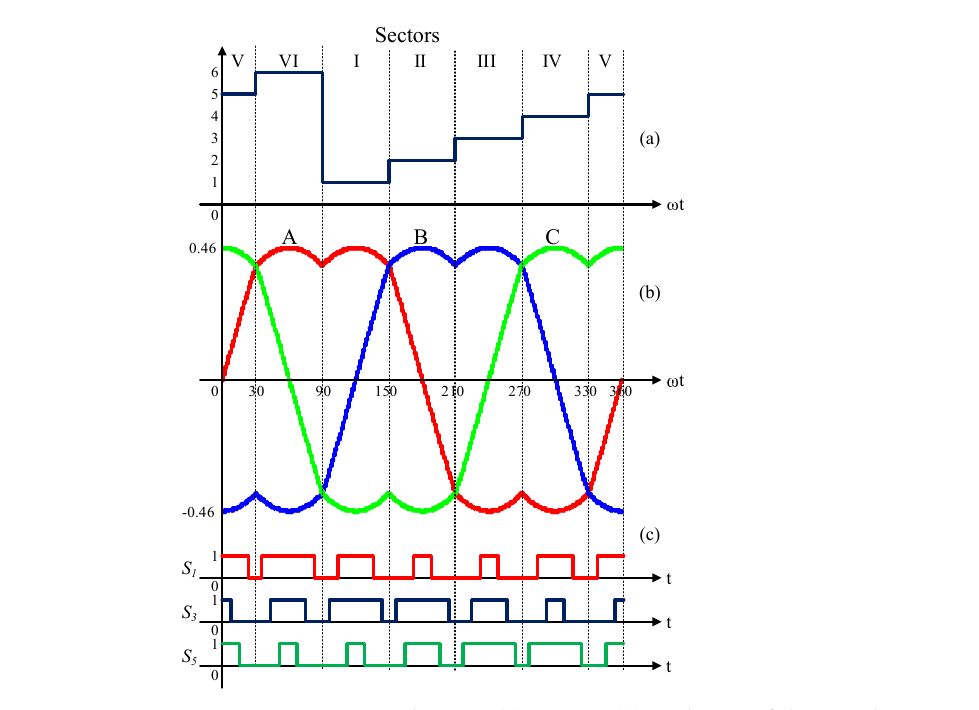
Figure 5. From top to bottom, ( a ) sectors; ( b ) evolution of the switching times t a , t b , and t 0 ; and ( c ) switching sequences for S 1 , S 3 , and S 5 in a conventional three-phase full-bridge inverter.